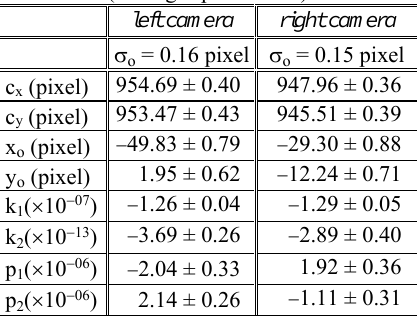
Independent calibration of the two cameras (8 images per